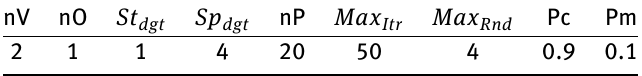
Table 13: VSSCGA Settings for Rosenbrock’s function with 2 variables